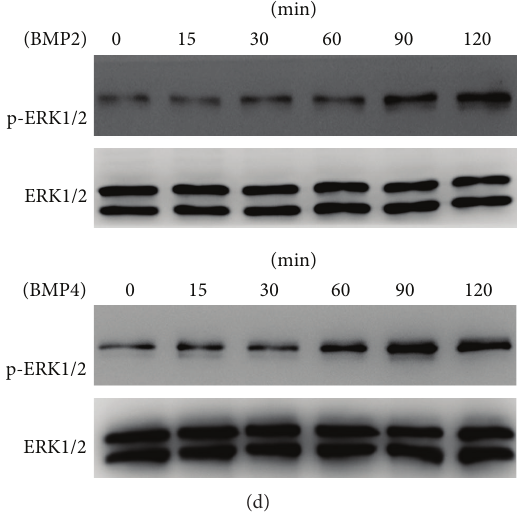
Figure 3: (a) Western blotting determined the expression of phosphorylated NF- 𝜅 B in IEC-6 after treatment with BMP2 and BMP4 for 6 h. The phosphorylated NF- 𝜅 B significantly increased compared with the control group, ∗∗ 𝑃 < 0.01 versus control. Noggin partially decreased NF- 𝜅 B transcriptional activity. ∗ 𝑃 < 0.05 , different from a single treatment with BMP2 or BMP4. (b) Immunofluorescence detected the translocation of NF- 𝜅 B to the nucleus after treatment with BMP2 and BMP4 for 30 min, and noggin partially reversed the nuclear localization of NF- 𝜅 B. (c) The fluorescence intensity of phosphorylated NF- 𝜅 B was significantly increased in the I/R group compared to the sham group. In the I/R group, NF- 𝜅 B exhibited significant nuclear localization in the distal villus, where abundant BMP2 and BMP4 are secreted after I/R (as shown in Figure 1(c)). The abundant BMP2 and BMP4 directly activated NF- 𝜅 B resulting in its nuclear localization, and noggin decreased the nuclear localization of NF- 𝜅 B in the I/R + noggin group. (d) Western blotting detected ERK expression upon BMP2 and BMP4 treatment at the defined time points. Phosphorylated ERK1/2 expression progressively increased in a time-dependent